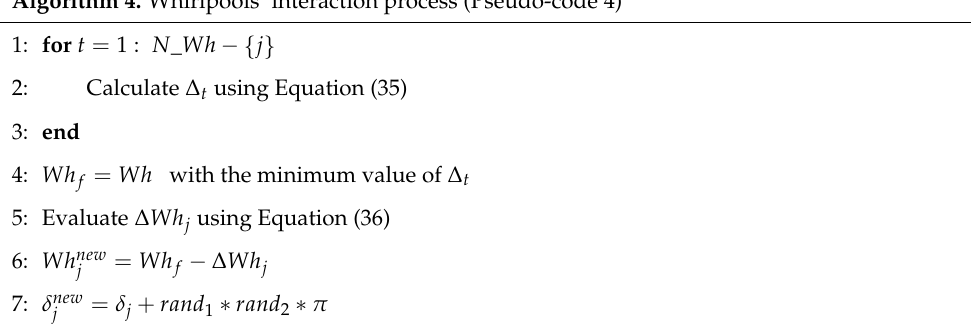
Algorithm 4. Whirlpools’ interaction process (Pseudo-code